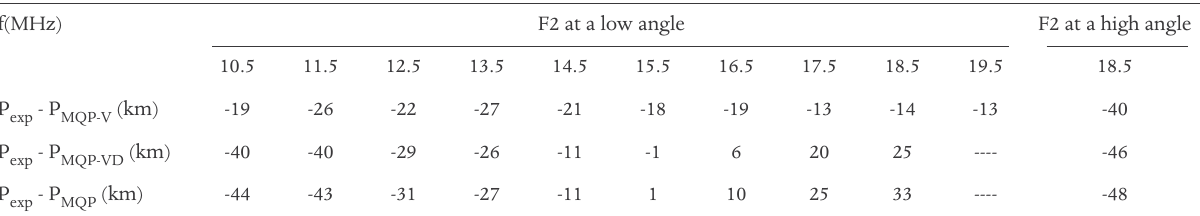
Table 2. Difference values in the one-hop group paths of the experimental oblique sounding and of the simulation results. Time: January 4, 2014, at 03:07